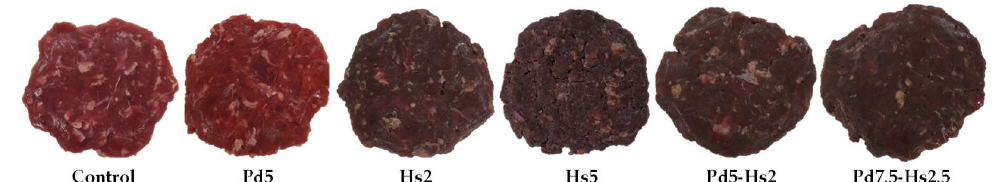
Figure 1. Visual aspect of the beef burgers formulated after the preparation and considering the six treatments: control, Pd5 (5% Pleurotus djamor powder), Hs2 (2% Hibiscus sabdariffa powder), Hs5 (5% Hibiscus sabdariffa powder), Pd5-Hs2 (5% Pleurotus djamor powder with 2% Hibiscus sabdariffa powder), and Pd7.5-Hs2.5 (7.5% Hibiscus sabdariffa powder with 2.5% Hibiscus sabdariffa powder).